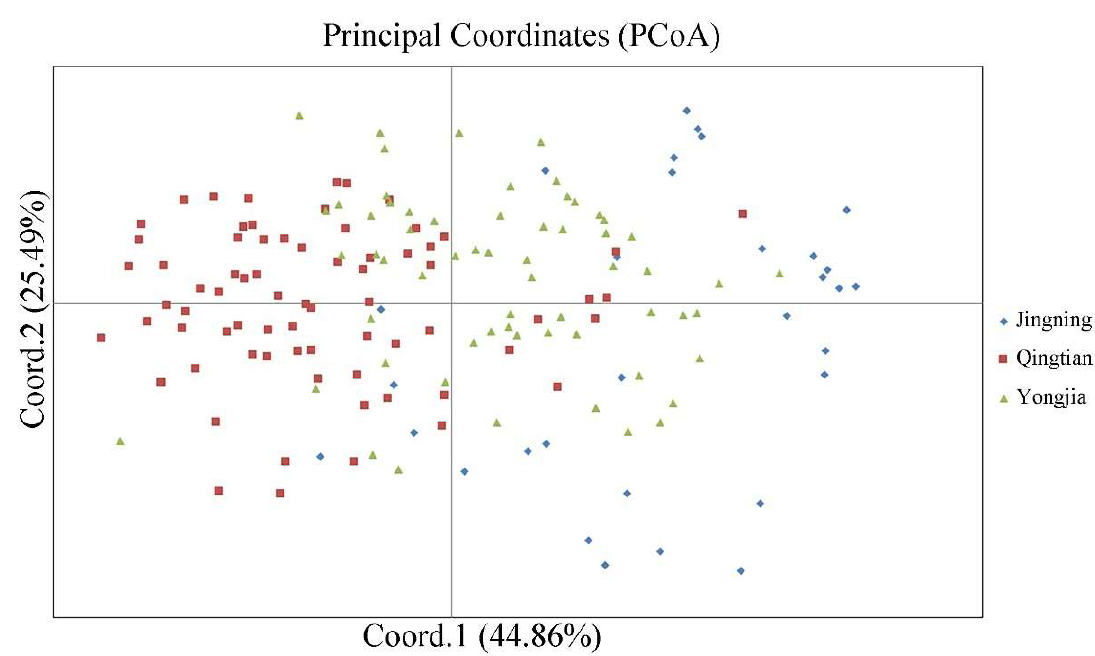
Figure 5. Principal coordinates analysis of the sampled carp based on Fst values.